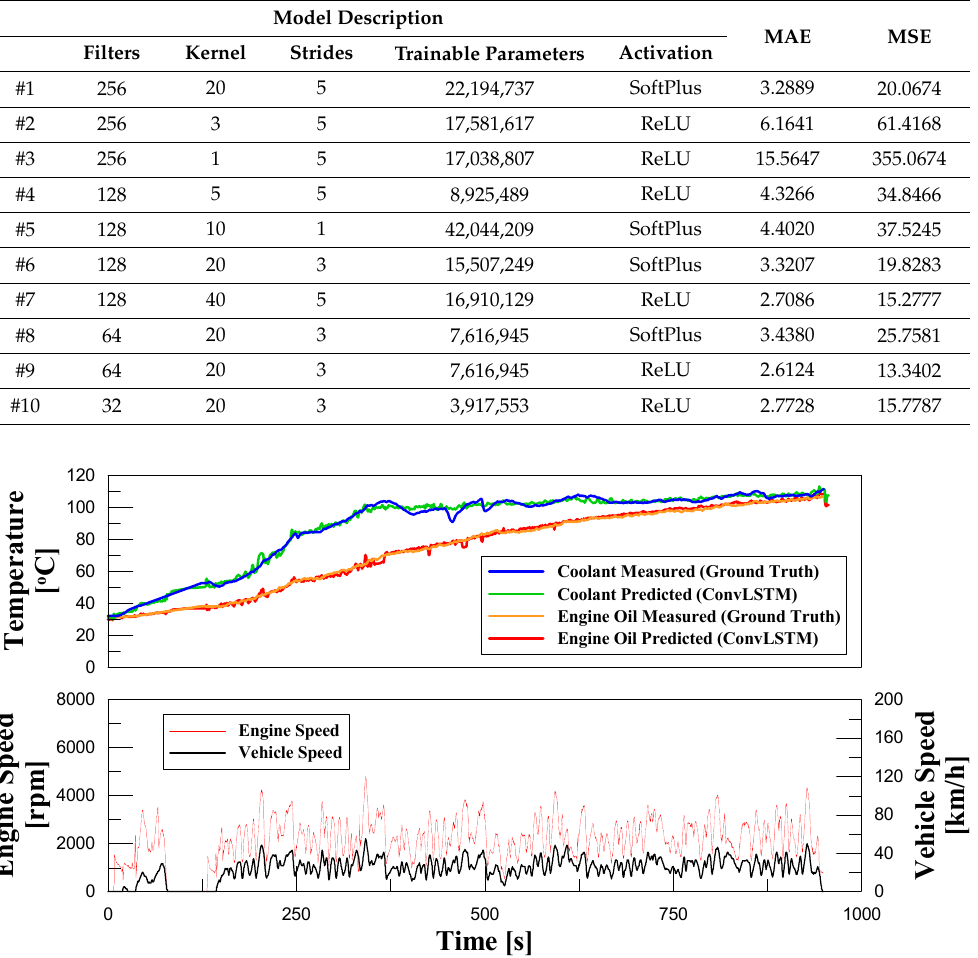
Figure 10. On-road example of Neural Network (Convolutional LSTM) based coolant and engine oil temperature prediction and comparison of actual measurements. Data used in the on-road experiment of physics-based modeling are considered here.